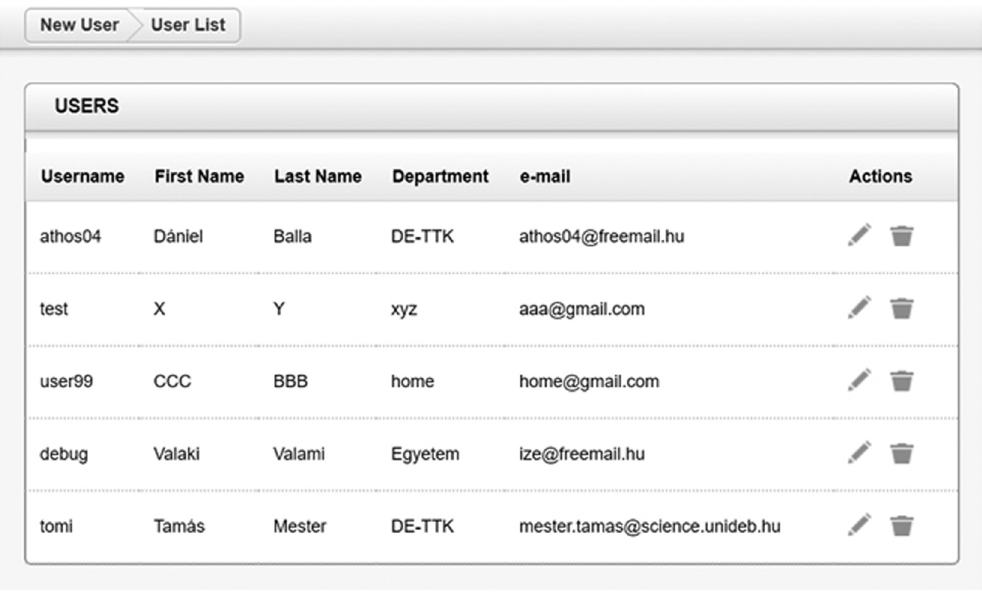
Figure 19: Interface of the Edit User menu.